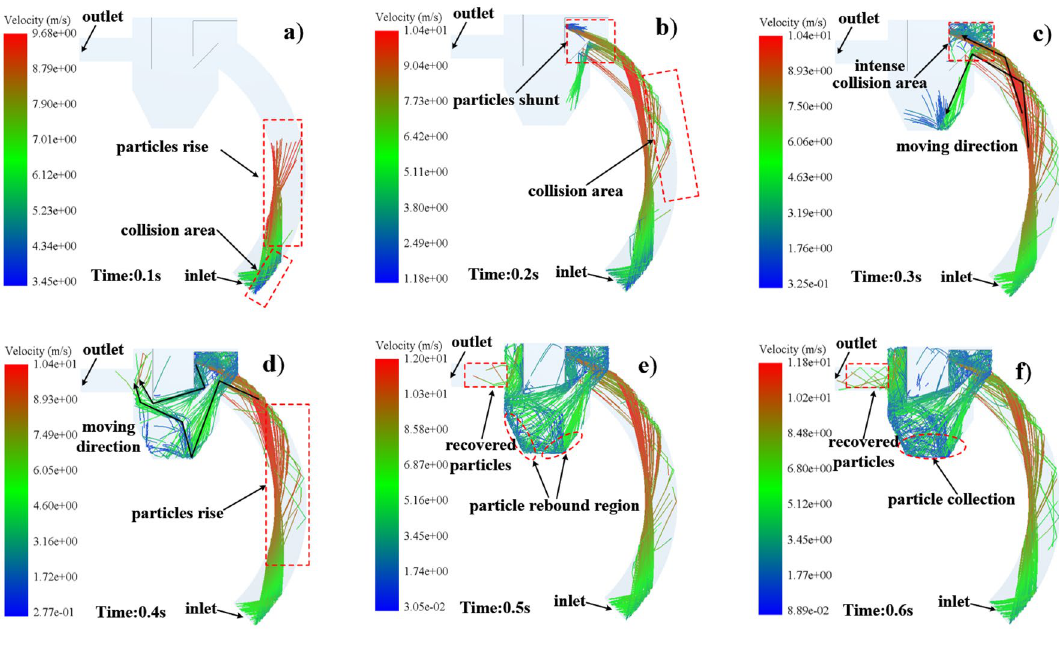
Figure 11. Velocity and trajectory of waste material particles